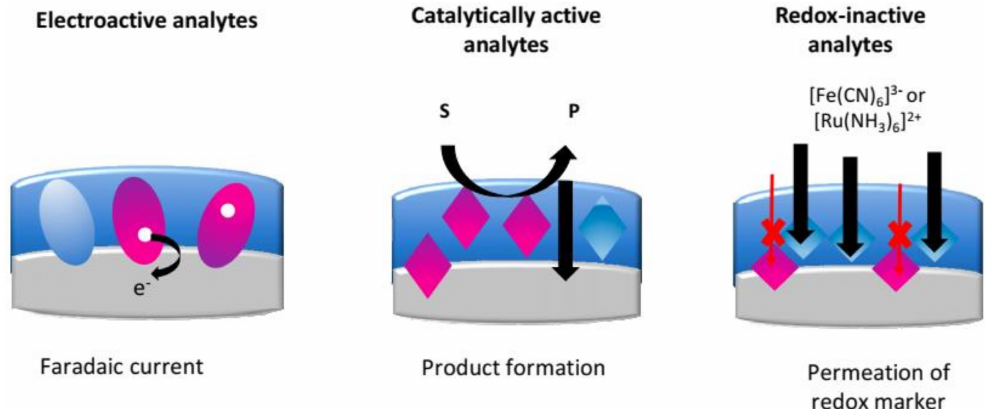
Figure 2. Schematic outlining the main detection methods used in electrochemical MIP-based sensors. Figure reproduced from [46].